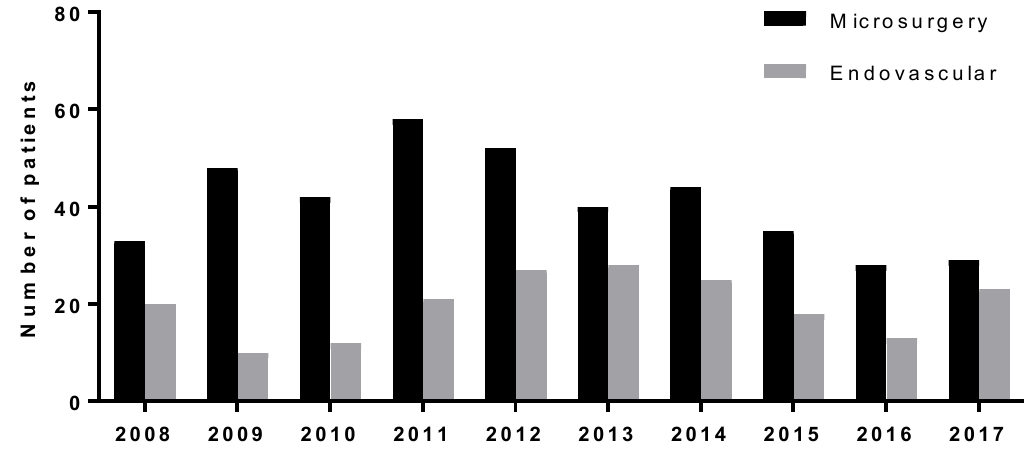
Figure 2. Proportion of both modalities for the period 2008–2017.